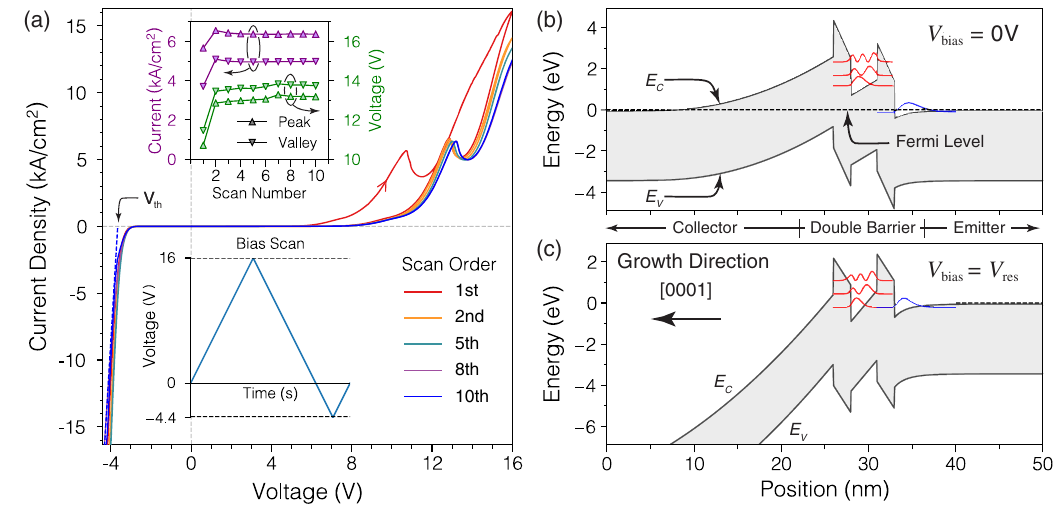
FIG. 2. (a) Current-voltage characteristics of GaN = AlN RTDs with their layer structure shown in Fig. 1(a). The measurements, performed at room temperature, were obtained by applying closed-loop bias scans as shown in the bottom inset. Subsequent closed-loop measurements were performed on the same device featuring a mesa area of ∼ 24 μ m 2 . A shift in the peak voltage is observed during the first closed-loop scan; however, it disappears in the following scans. The onset of NDC stabilizes at ∼ 13 . 2 V with a repeatable peak current density of ∼ 6 . 4 kA = cm 2 [top inset of (a)]. The stable RTD characteristics confirm the presence of resonant tunneling transport at room temperature with a minimum NDC of ∼ − 5 . 9 kS = cm 2 . (b) Band diagram under equilibrium conditions showing the accumulation subband in the emitter region and resonant states in the quantum well. (c) Band diagram under resonant conditions enabled by the energy alignment between the accumulation subband next to the emitter AlN barrier and the ground state of the quantum